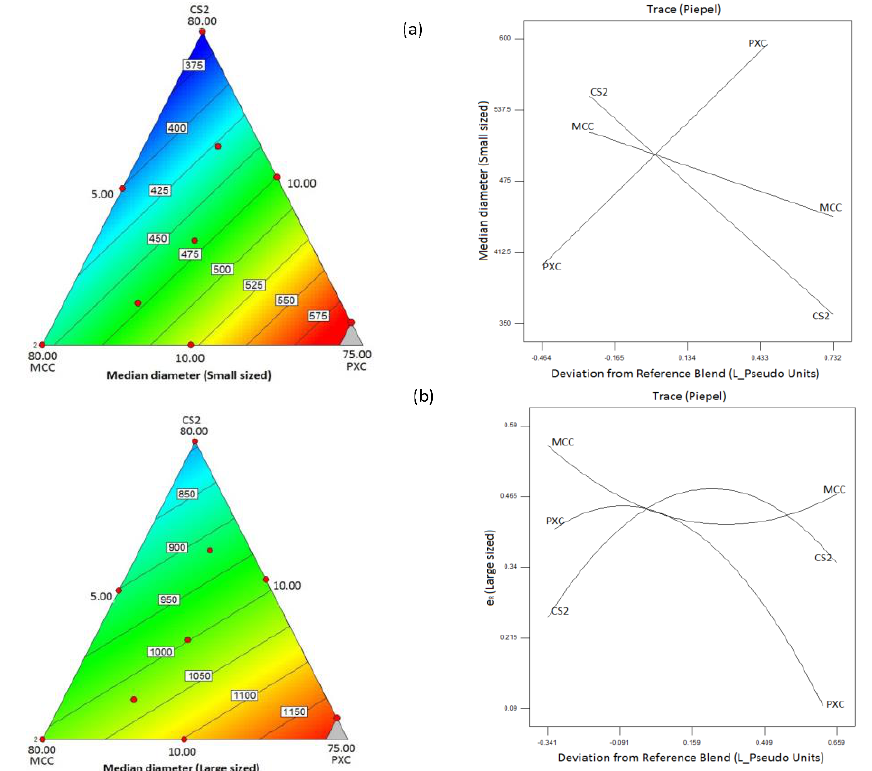
Figure 3. Contour and trace plots of mean pellet diameters for ( a ) mini and ( b ) conventional pellets.